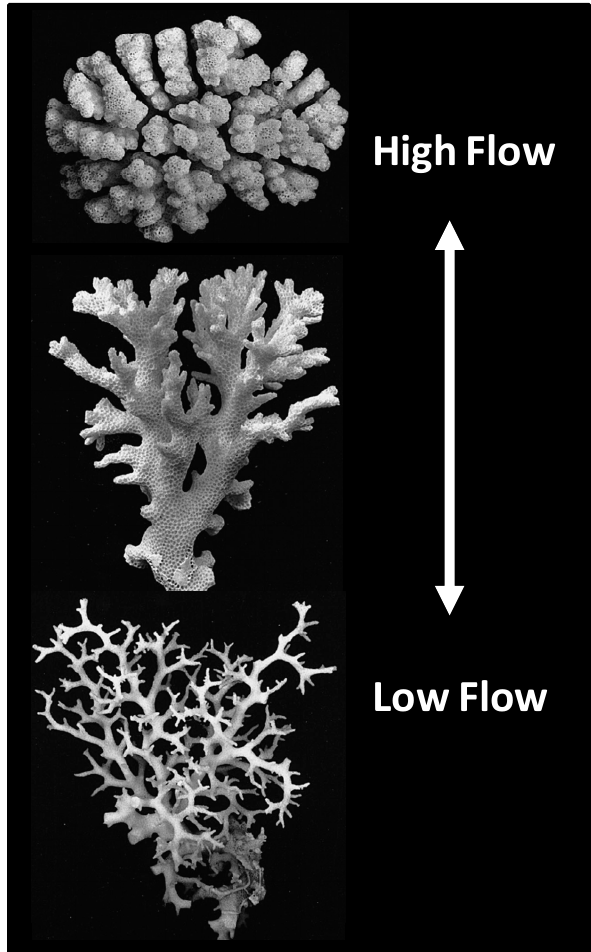
Fig. 9. A range of growth forms from a single species of P. dami- cornis (after Veron and Pichon,